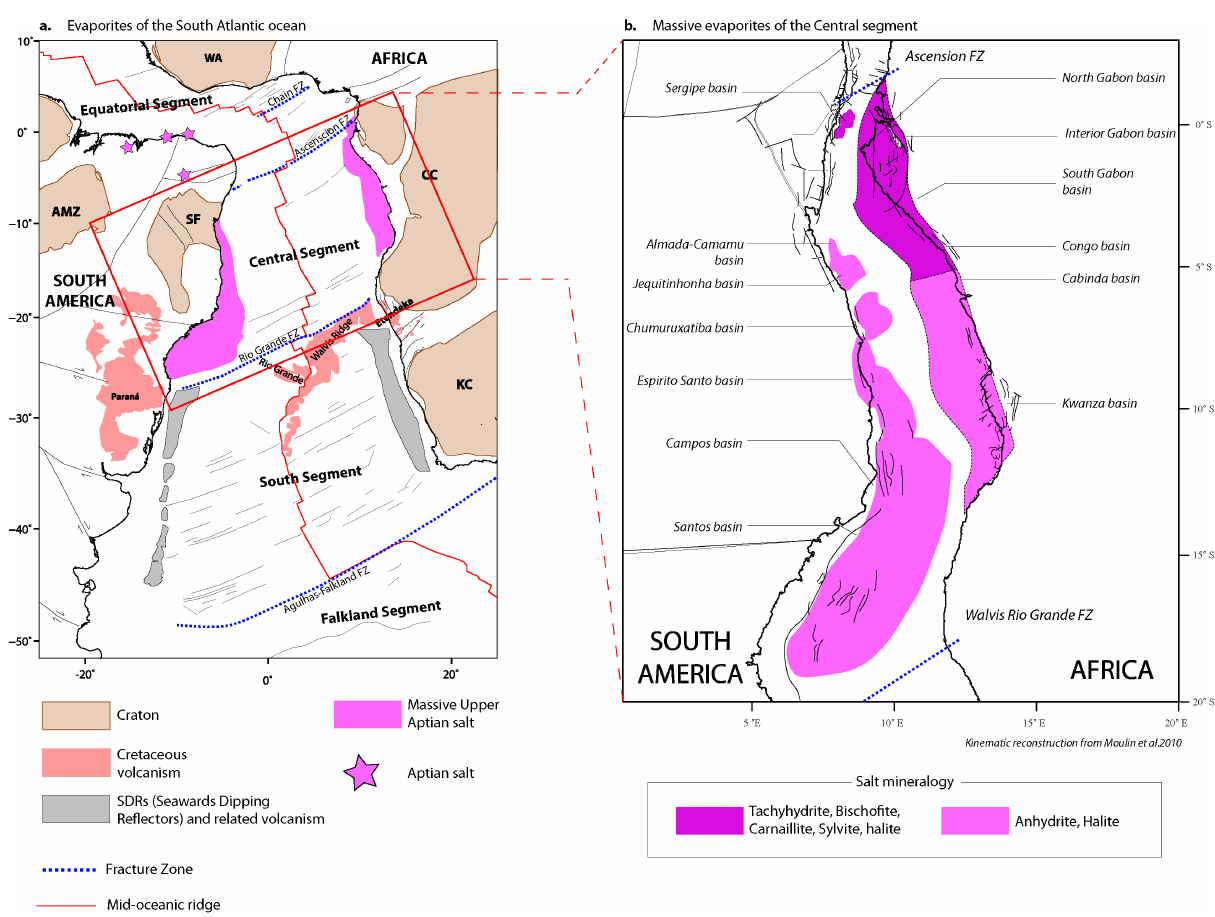
Fig. 1. (a) Location of the Central segment and the salt sequence along the Brazilian and African margin (modified from Moulin et al., 2010). WA, West Africa Craton; CC, Congo Craton; KC, Kalahari Craton; AMZ, Amazonia Craton; SF, S˜ao Francisco Craton; FZ, Fracture Zone. (b) Mineralogy of the massive evaporites in the Central segment, at time of filing, according to the cinematic reconstruction of Moulin et al.